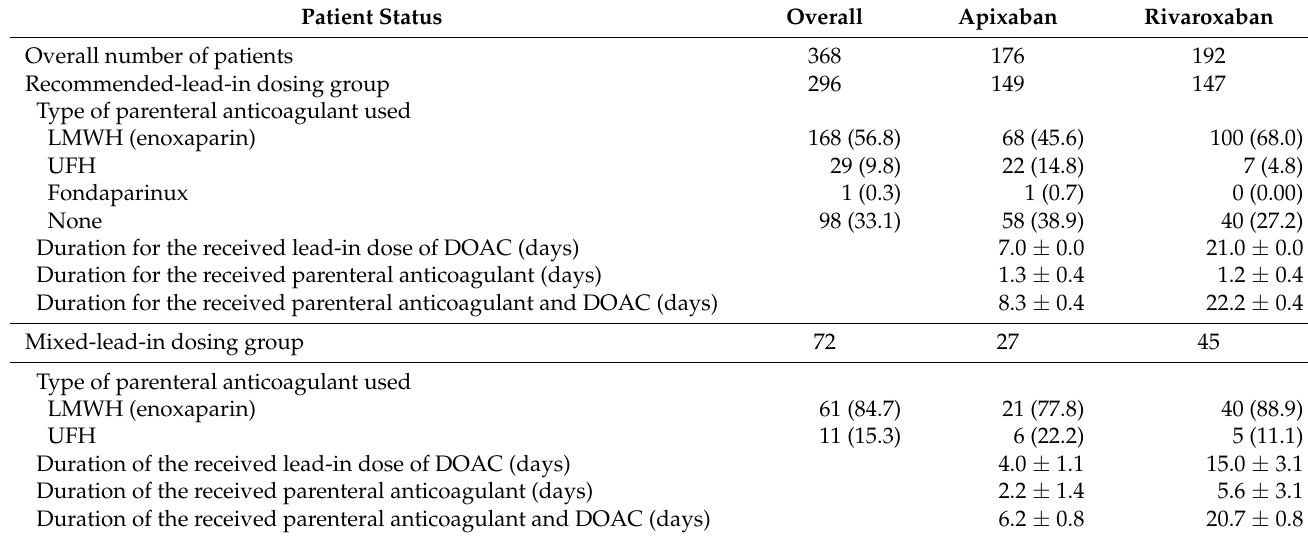
Table 4. Recommended vs. mixed-lead-in dosing for VTE